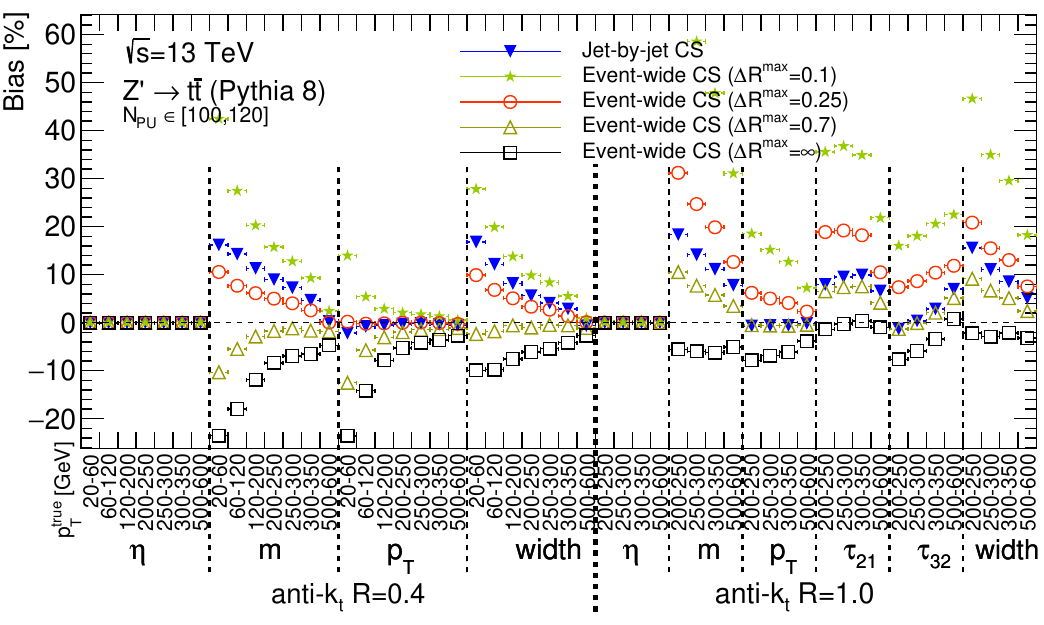
Figure 12. Dependence of bias on the (cid:1) R max parameter for the Event-wide CS. The other CS parameters are (cid:11) = 0 and A g = 0 : 0025.